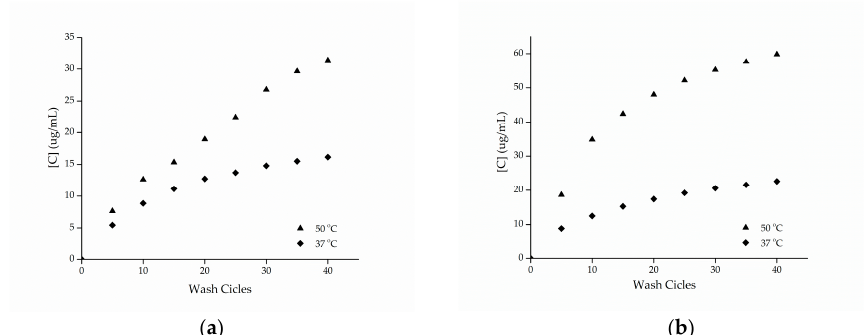
Figure 8. Release profile of methyl salicylate from samples of ( a ) cotton and ( b ) polyamide in the washing process.